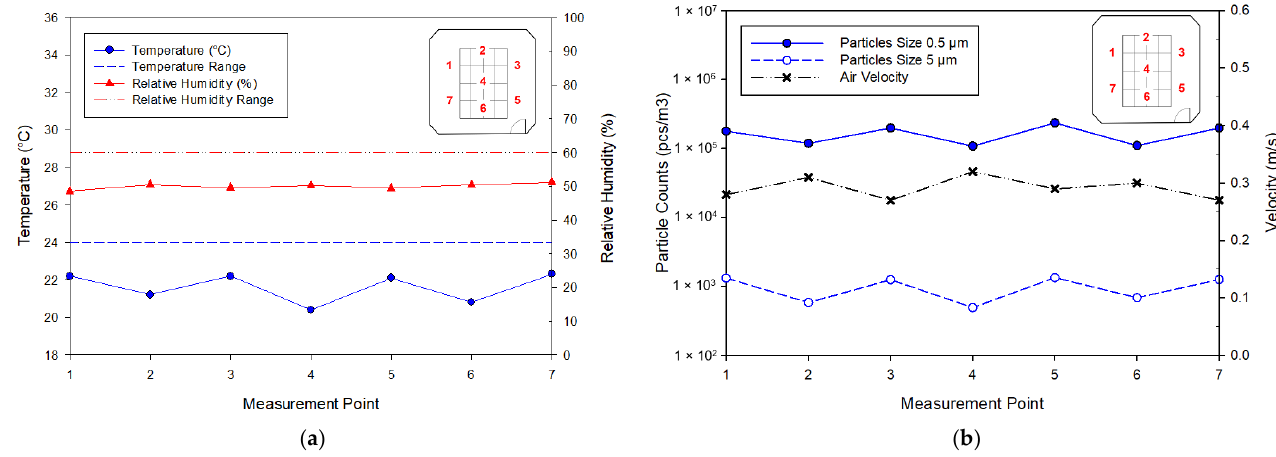
Figure 5. Field measurement test results, ( a ) temperature and relative humidity, ( b ) particle counts and air velocity.